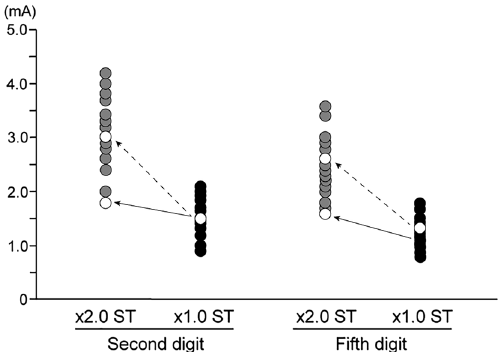
Figure 1. Stimulus intensity to second and fifth digits for sensory threshold and 2.0-times sensory threshold for synesthete B and 24 non-synesthetes. White circles indicate data on the stimulus intensity for synesthete B. Black circles show data on the stimulus intensity for 24 non-synesthetes. The sensory threshold (× 1.0 ST) for synesthete B is about the average of the 24 non-synesthetes. When set to twice the stimulus intensity, it is located at the value of the dotted arrow. However, synesthete B reported pain and an unpleasant sensation when the stimulus intensity was set to 2.0 times ST. Therefore, the stimulus intensity was set to 1.1 times ST, located at the value indicated by the arrow. ST sensory